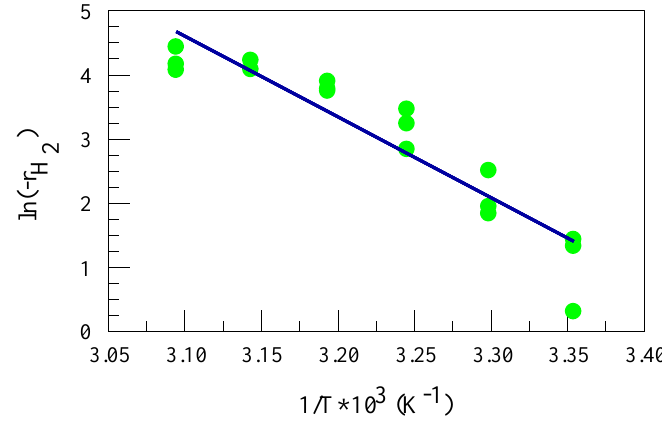
Figure 6. Arrhenius plot for all concentrations of NaBH